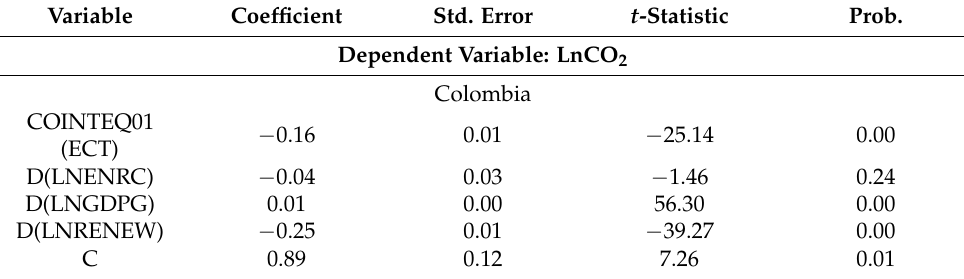
Table 8. Short Run Dynamics of Cross-Section